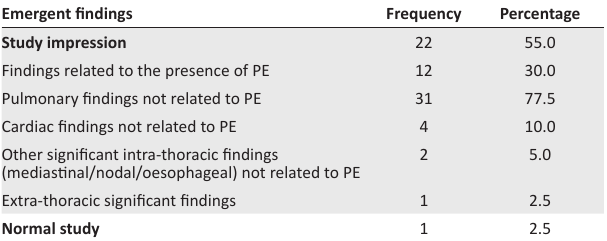
TABLE 4: Frequency and percentages for the presence of emergent findings and study